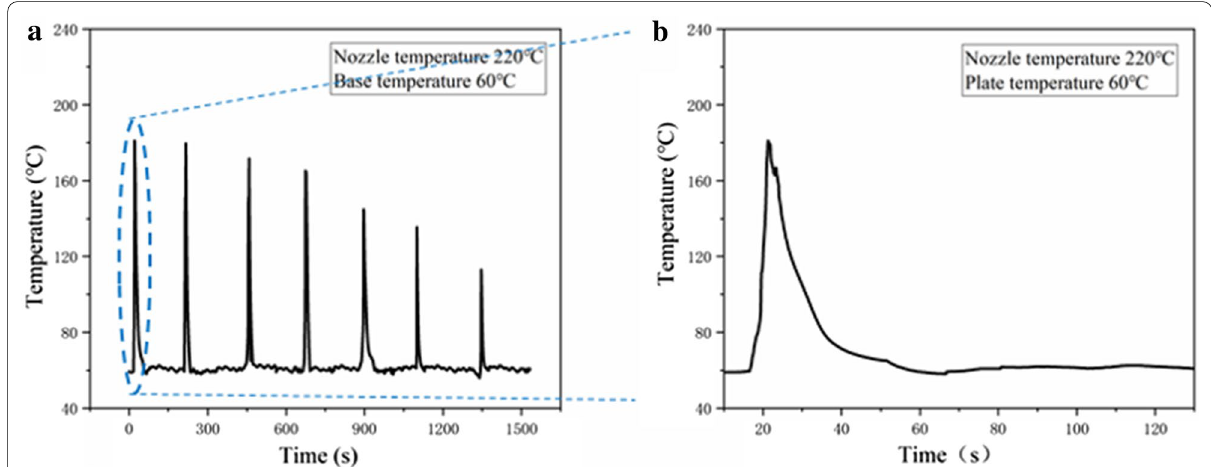
Figure 2 a Results of temperature monitored in printing process, b enlarged view of marked portion in